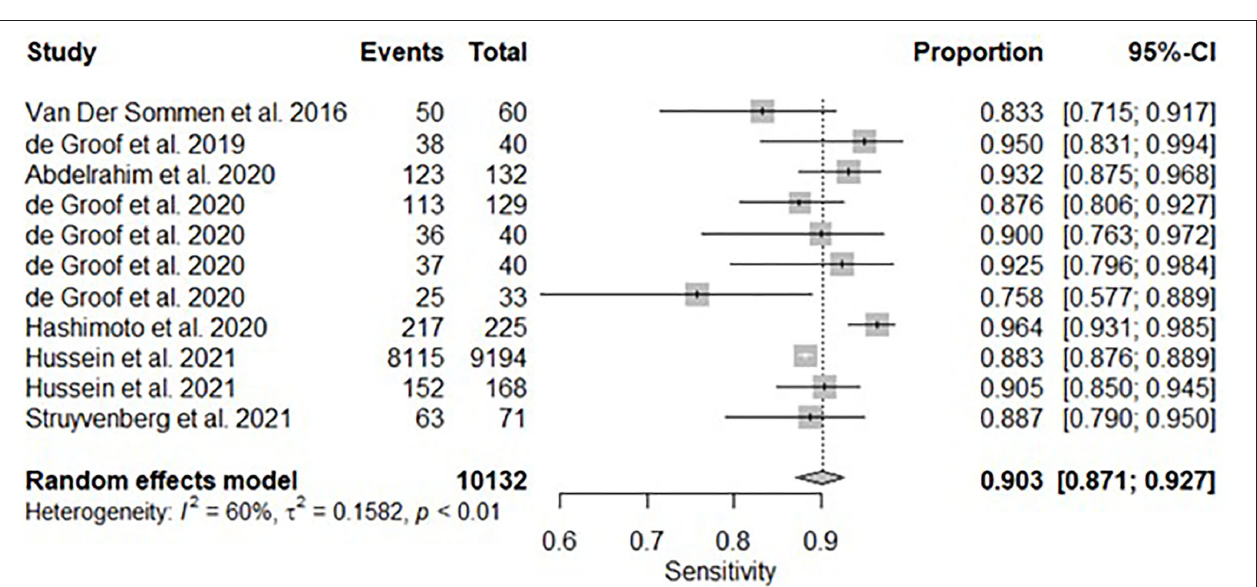
FIGURE 2 | Forest plots of pooled sensitivities for all included studies of AI and the detection of early BE neoplasia.